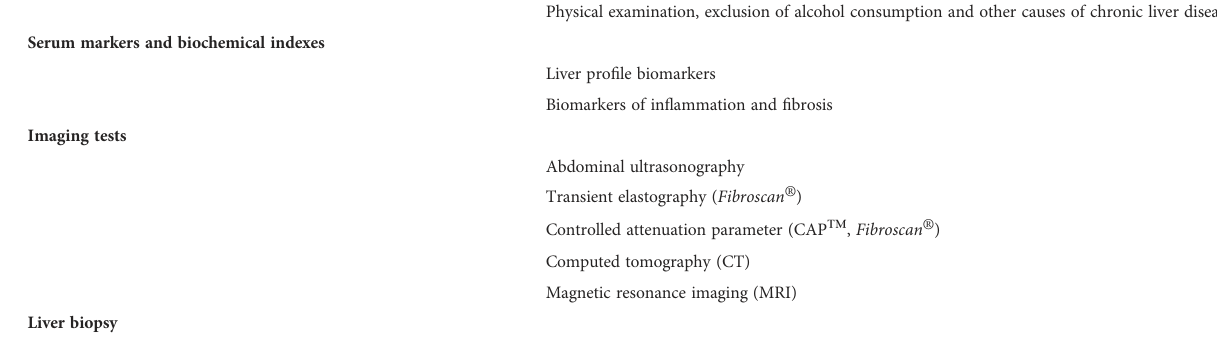
TABLE 1 Diagnostic assessment of NAFLD/NASH. Clinical examination